Question: State the chart type depicted above.
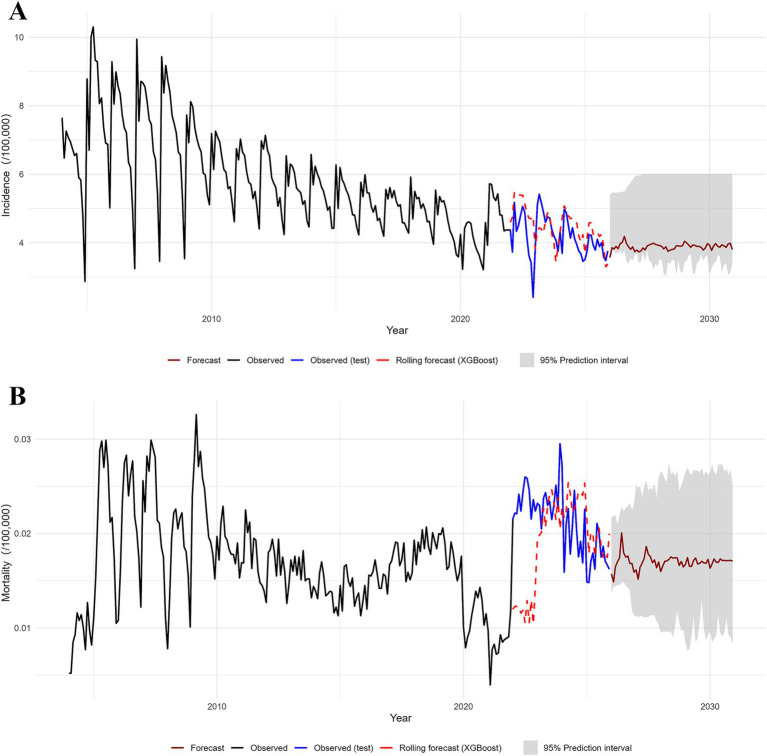
Answer: line